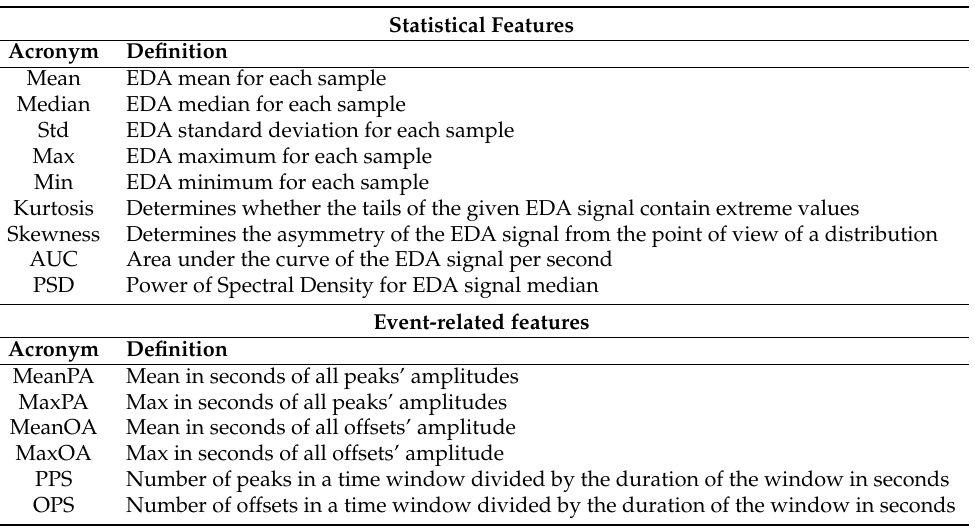
Table 1. Description of the features used in the